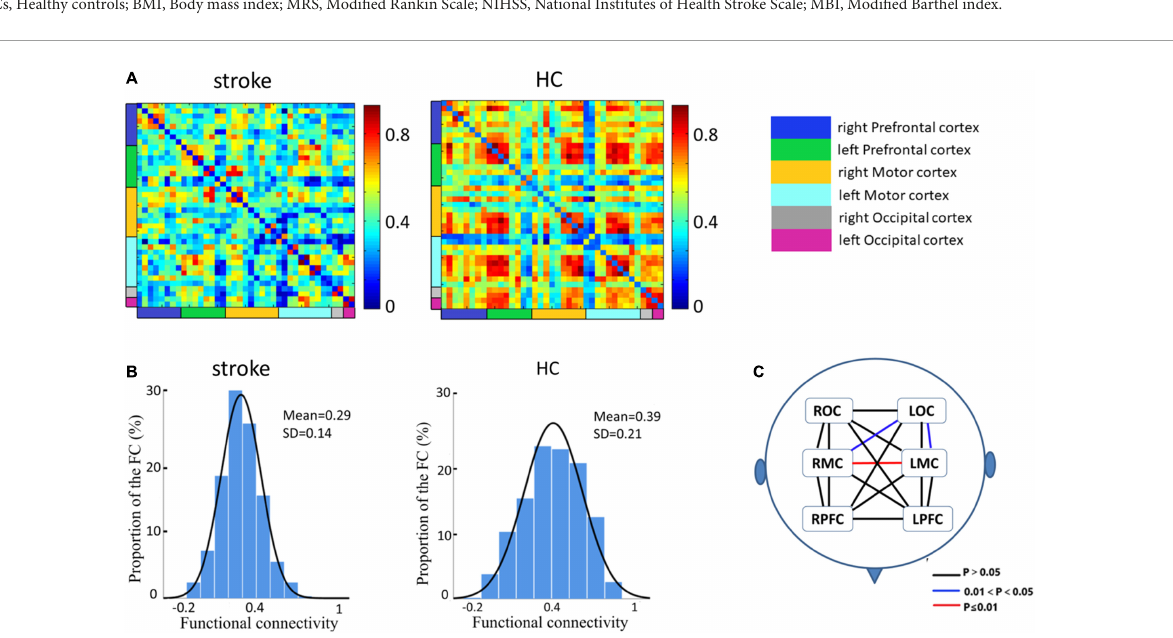
FIGURE2 Spatial patterns of the functional connectivity in the FNS state and resting state. (A) Networks of FNS-related changes in functional connectivity between stroke patients and HCs. (B) Histograms of functional connectivity distribution in the two groups. (C) Functional connectivity in patients with stroke showed significant decreases in different cerebral regions when compared with